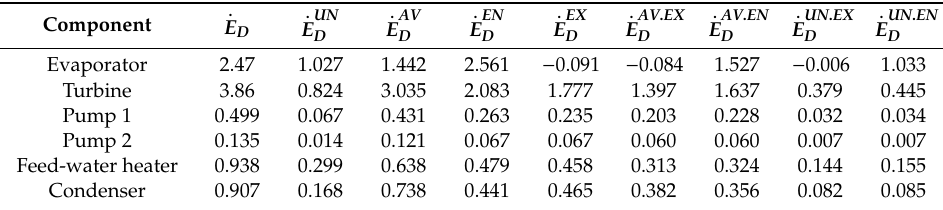
Table 9. Advanced exergy analysis results (kW) for SRORC.